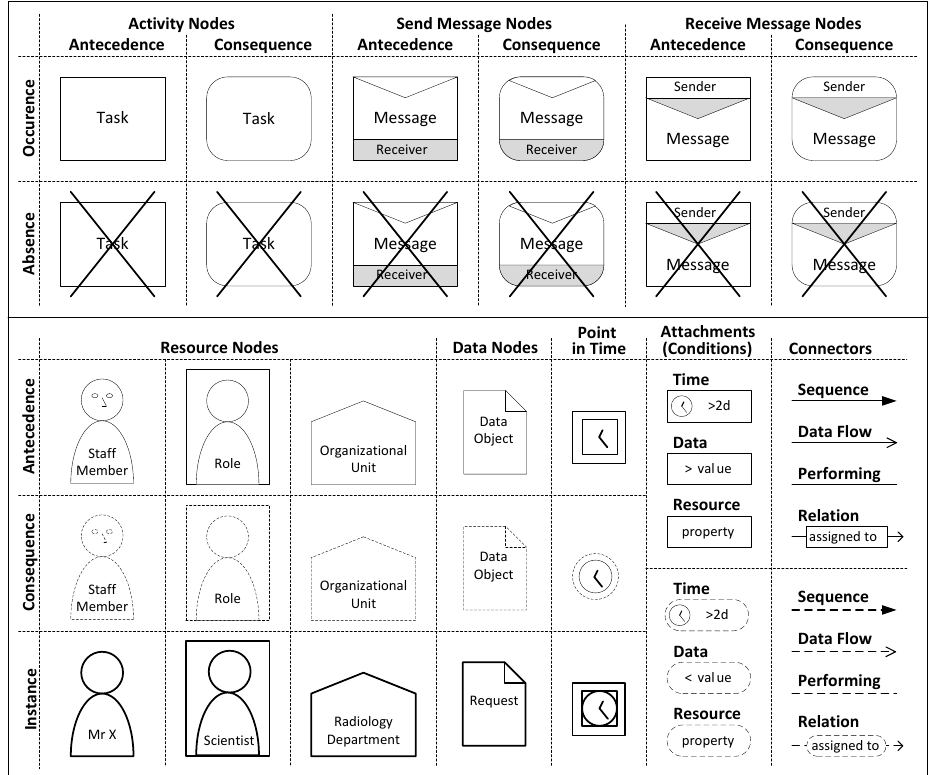
Figure 6. Excerpt of the eCRG